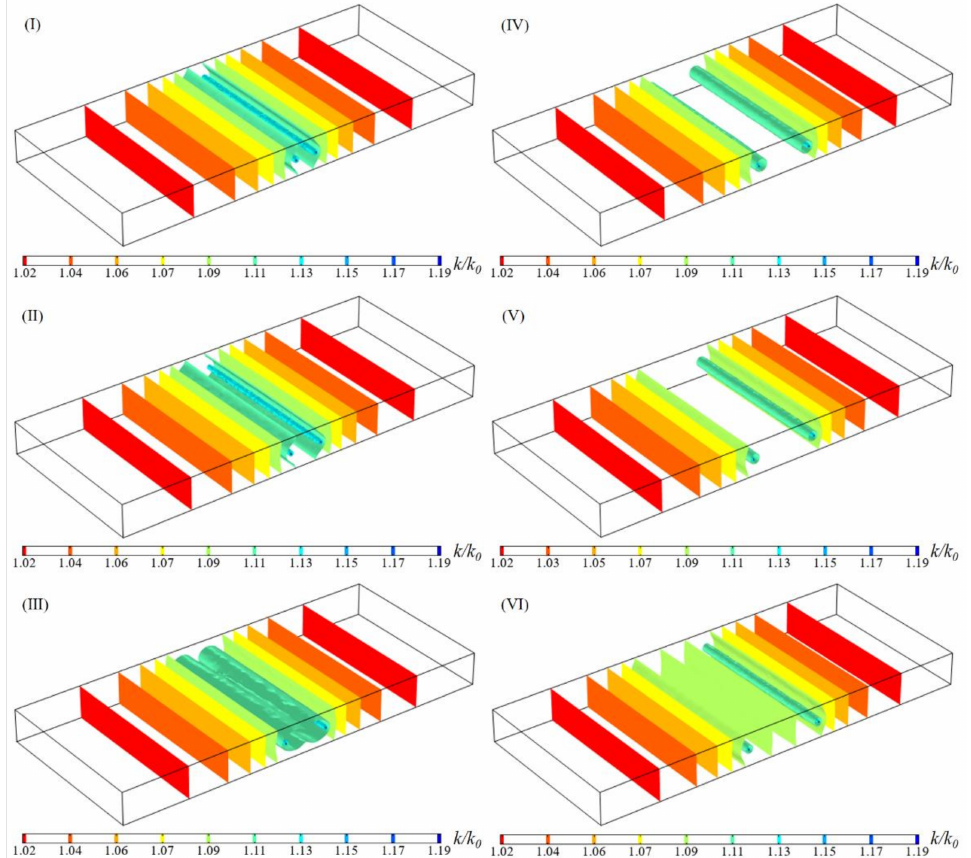
Figure 20. Three-dimensional cloud chart of permeability distribution around boreholes with different spacing: ( I) 4 m; ( II ) 6 m; ( III ) 8 m; ( IV ) 10 m; ( V ) 12 m; ( VI ) 14